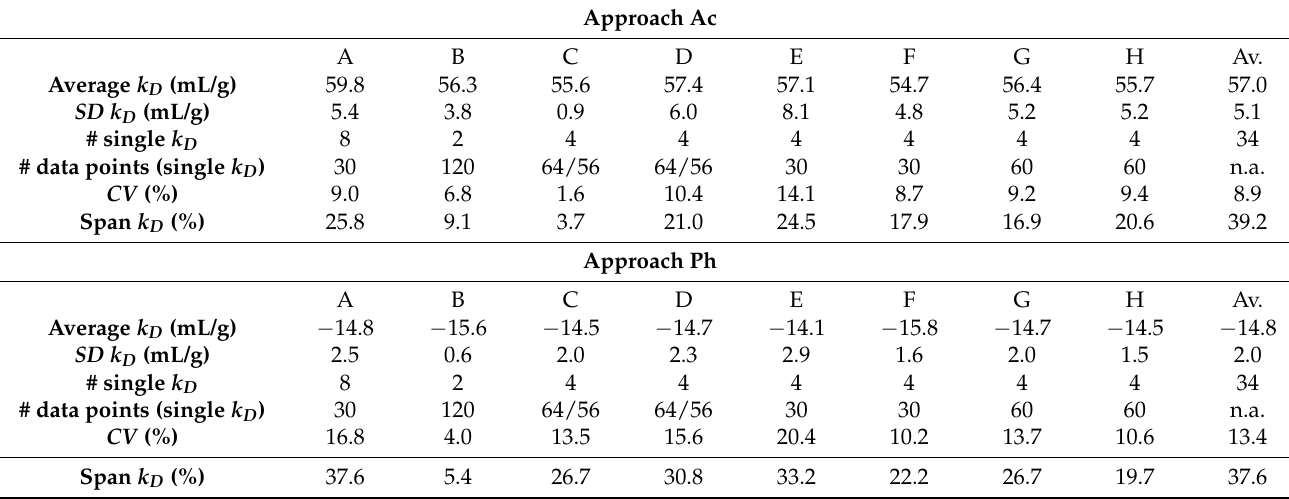
Table 1. Comparison between approaches to calculate the diffusion self-interaction parameter ( k D ) of peptide-12 in (Approach Ac) acetate buffer, pH 4.5, and (Approach Ph) in phosphate buffer, pH 6.0. In order to ensure comparability of the k D , the diffusion coefficients were submitted to a Grubbs’ test. Detected outliers were excluded from the dataset and not used for the k D calculations. The average intra-plate coefficient of variation ( CV ) was obtained by averaging the individual CV . The total averaged k D , including 34 k D obtained by 8 approaches (A–H), is shown in the right column. “# data points (single k D )” describes the number of sample replicates with regards to each concentration for the single k D determination (e.g., 6 replicates at 5 concentrations = 30 data points). “Span k D ” is defined as percentage difference between the considered k D and total averaged k D